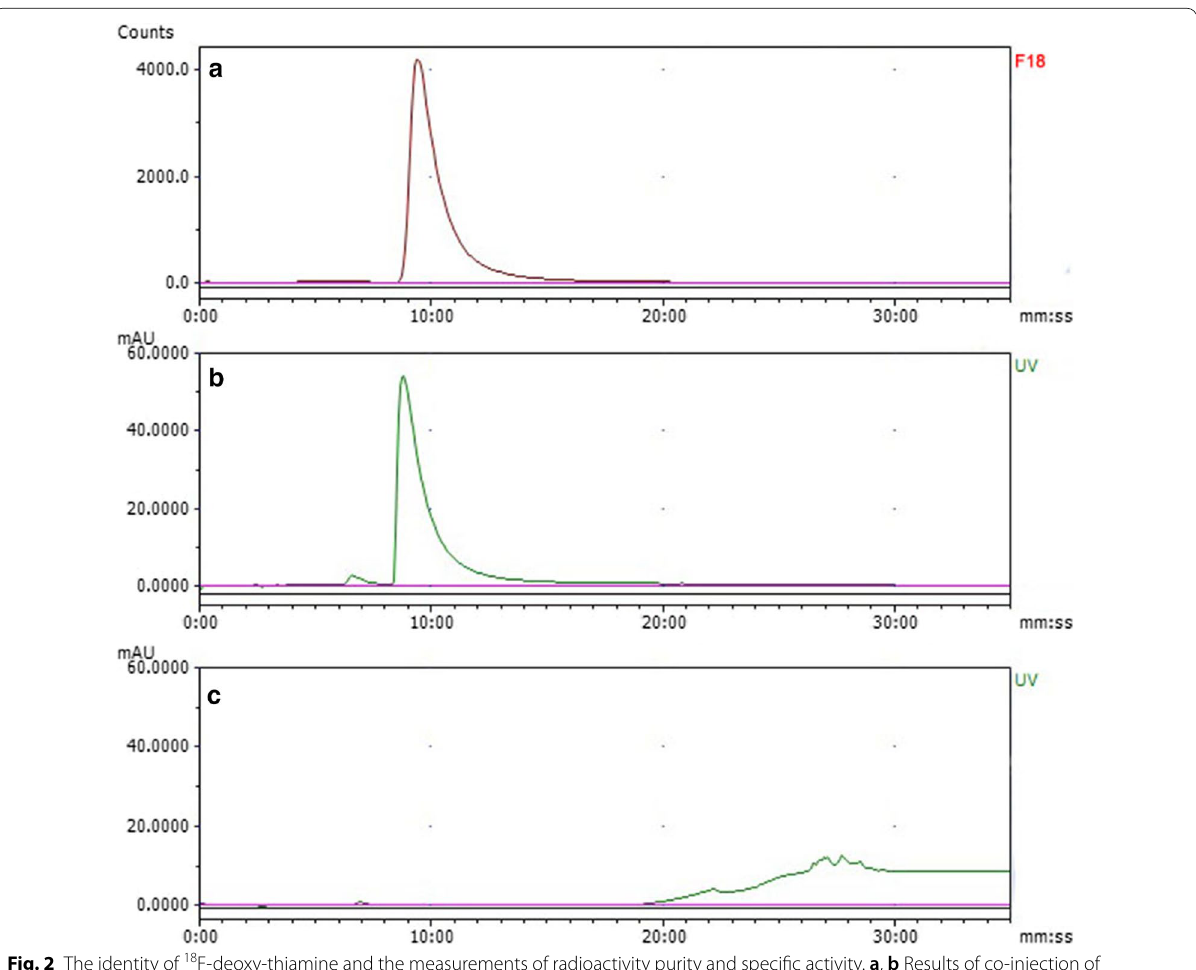
Fig. 2 The identity of 18 F-deoxy-thiamine and the measurements of radioactivity purity and specific activity. a , b Results of co-injection of 18 F-deoxy-thiamine with cold standard sample. a was the radio-signal, and the retention time was 9 min 24 s; b was the UV-signal, and the retention time was 8 min 47 s. Radio-signal acquisition system was installed behind UV-signal acquisition system, and the time-lag was about half-minute at the flow rate of 0.8 ml/min. Note that the peak shapes of a , b were the same. c the UV signal of 18 F-deoxy-thiamine. UV